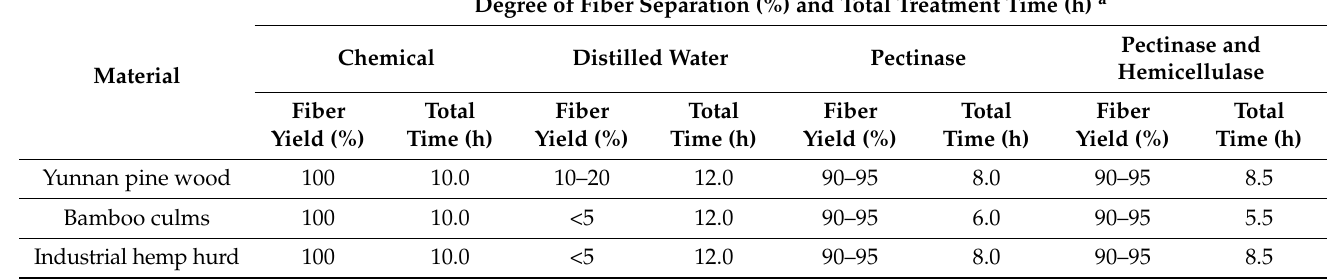
Table 2. Effect of chemical treatment alone or coupled with three sequential enzyme treatments on fiber yield and total treatment time of Yunnan pine wood, bamboo culms, and industrial hemp hurd fibers.